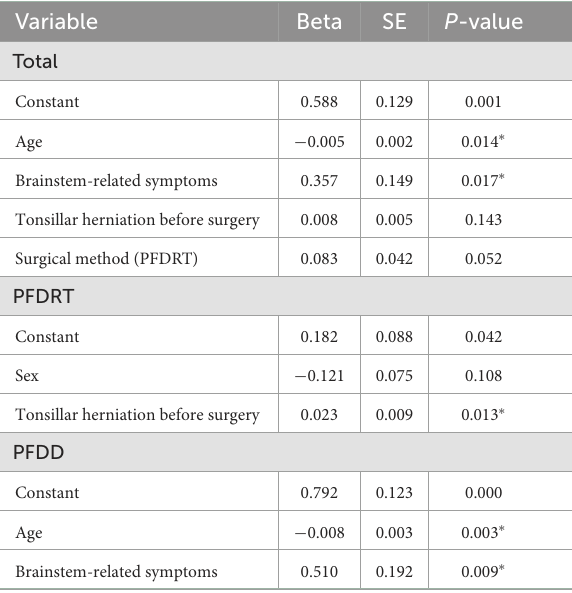
TABLE 6 Syrinx remission rate multiple regression